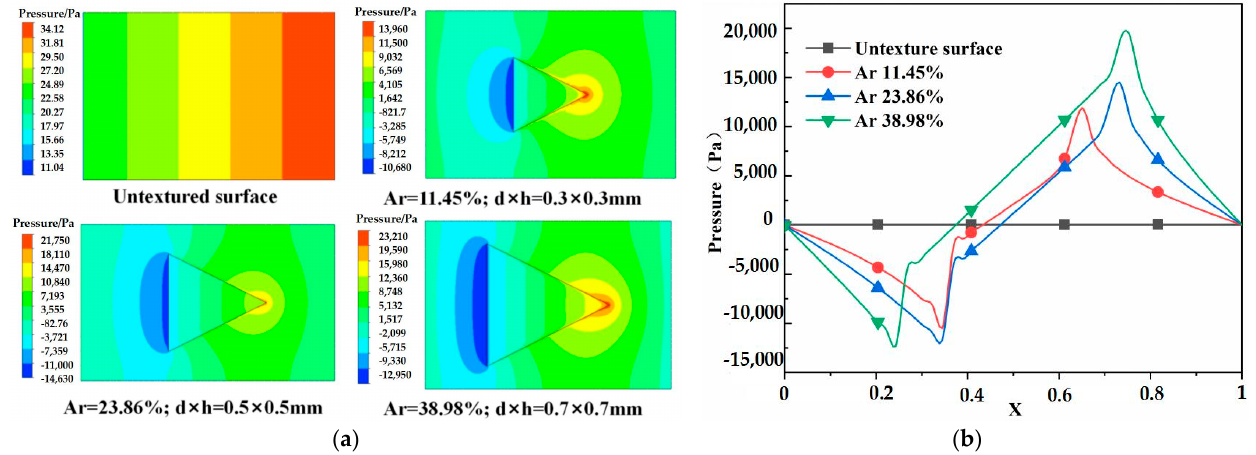
Figure 17. Pressure distribution of upper wall and oil film center pressure curve with different texture area occupancies. ( a ) Pressure distribution on the wall surface of the oil film (Pa). ( b ) Oil film center pressure distribution curve.